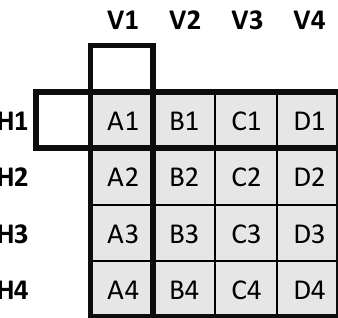
Figure 10. Utilised 2D sensor array. V1,…, V4 are the DOA of the columns and H1,…, H4 are the DOA of the rows estimated by the MUSIC algorithm.